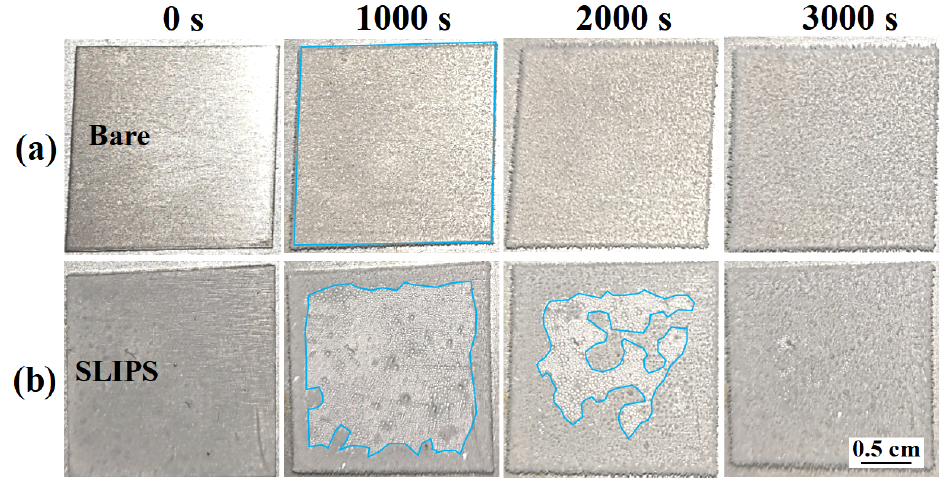
Figure 6. The frosting process of a bare aluminum surface ( a ) and SLIPS ( b ) at − 10 °C. The areas within the blue markings in the fi gure are the frosted areas of samples.